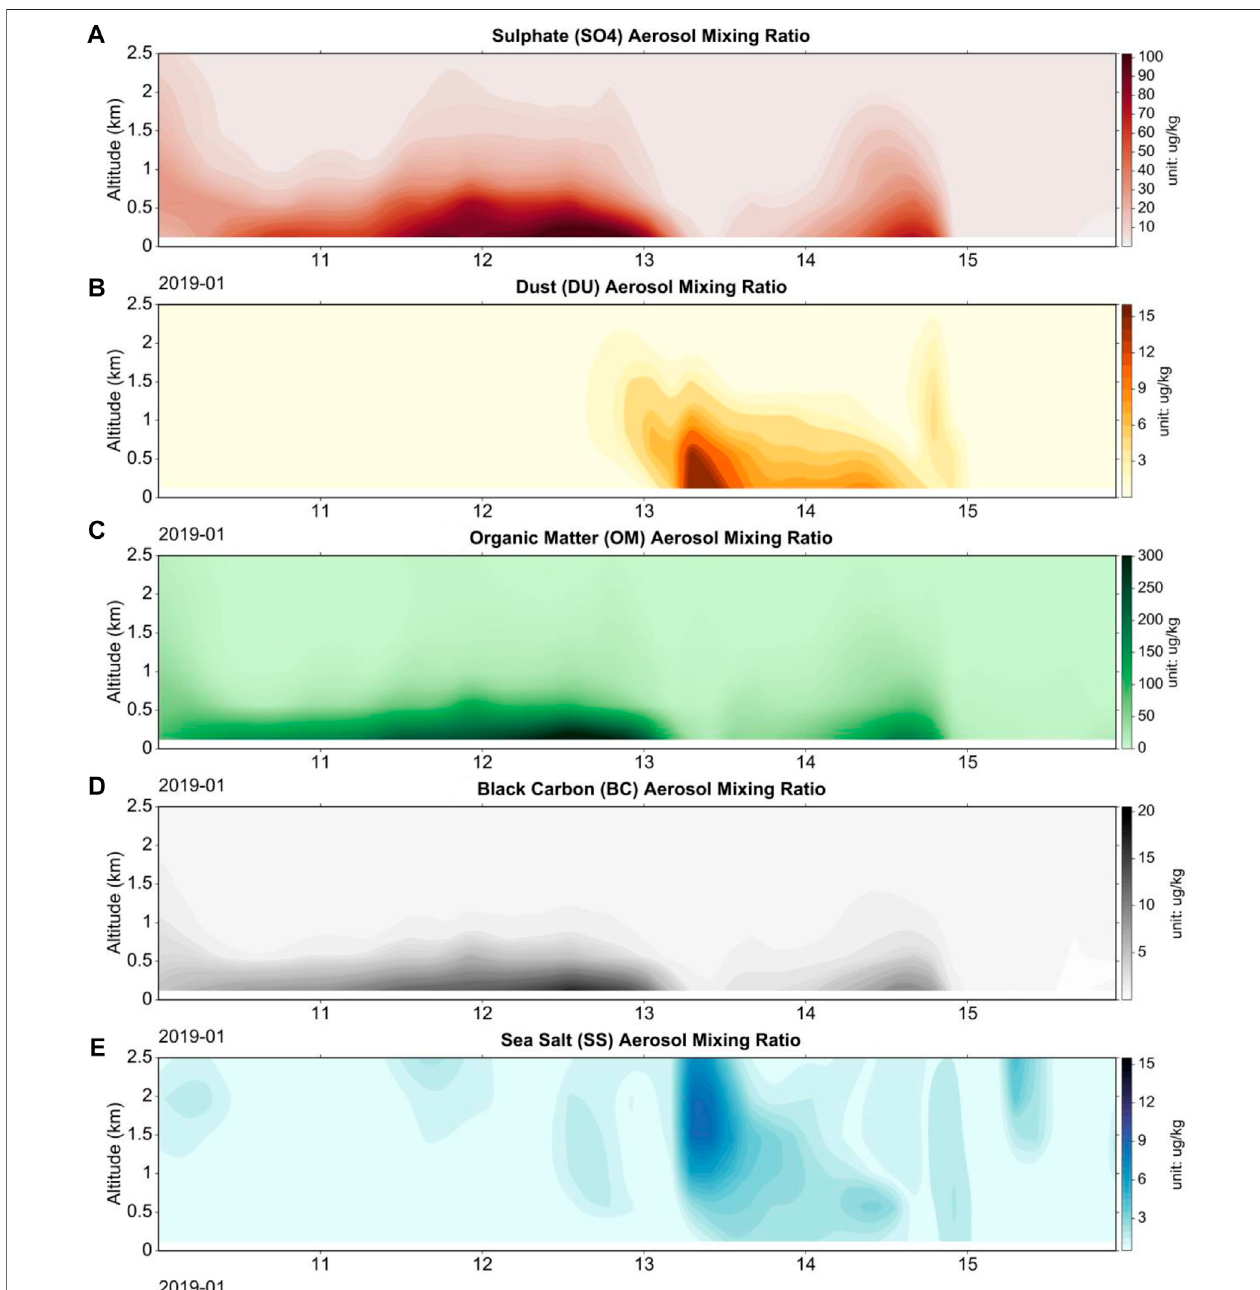
FIGURE 10 | Time – height distribution of mixing ratios by aerosol type (A) SO4, (B) DU, (C) OM, (D) BC, and (E) SS from 10 to 15 January 2019 in Tianjin.